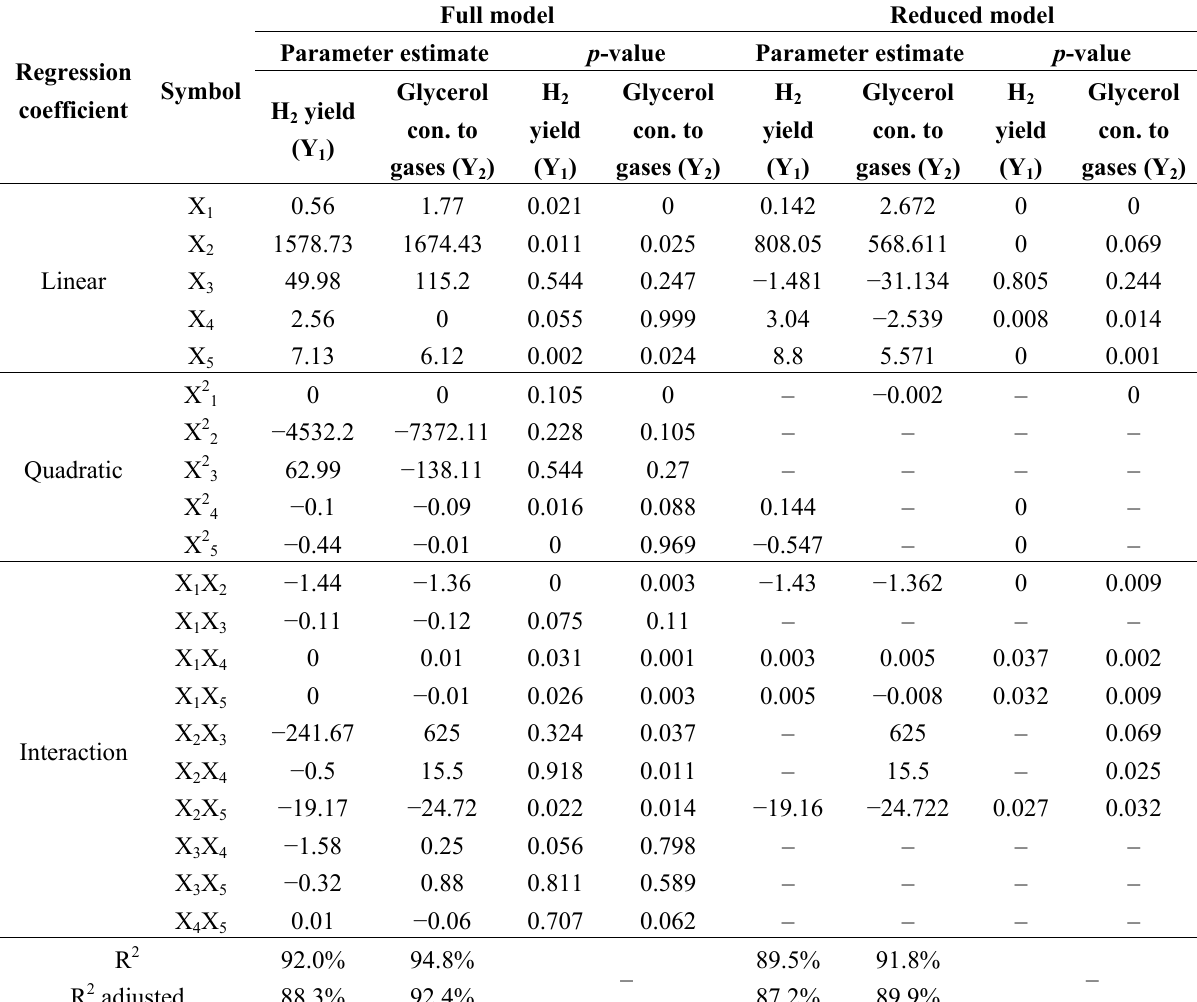
Table 4. Full model and reduced model coefficient parameters for both